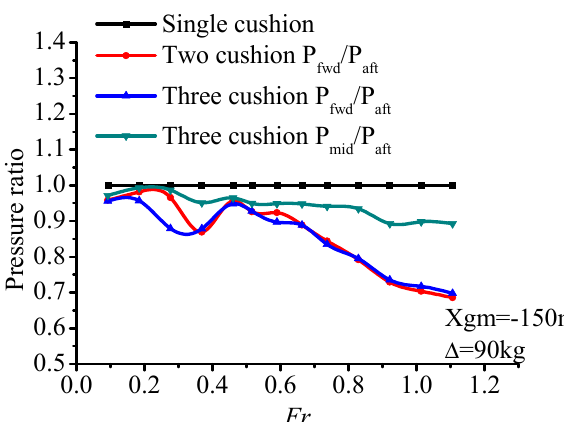
Figure 25. Comparison of models’ trim angle.